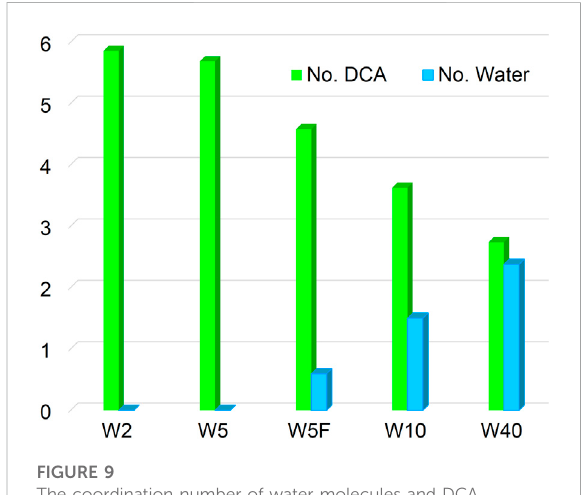
FIGURE 9 The coordination number of water molecules and DCA anions around Na +